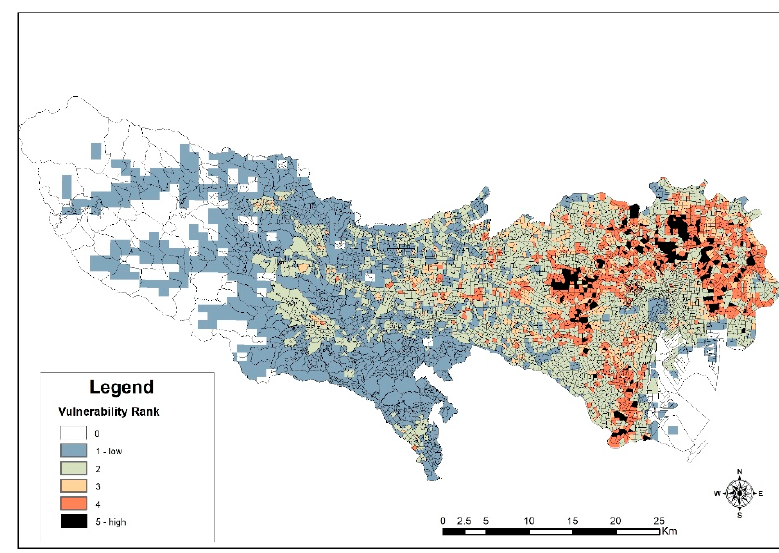
Figure 7. Vulnerability areas for non-Japanese. Table 1. Calculated areas of risk categories.